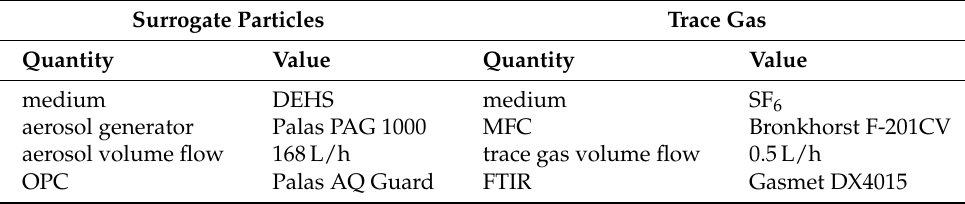
Table 1. Relevant parameters of the measurement devices. Surrogate Particles Trace Gas Quantity